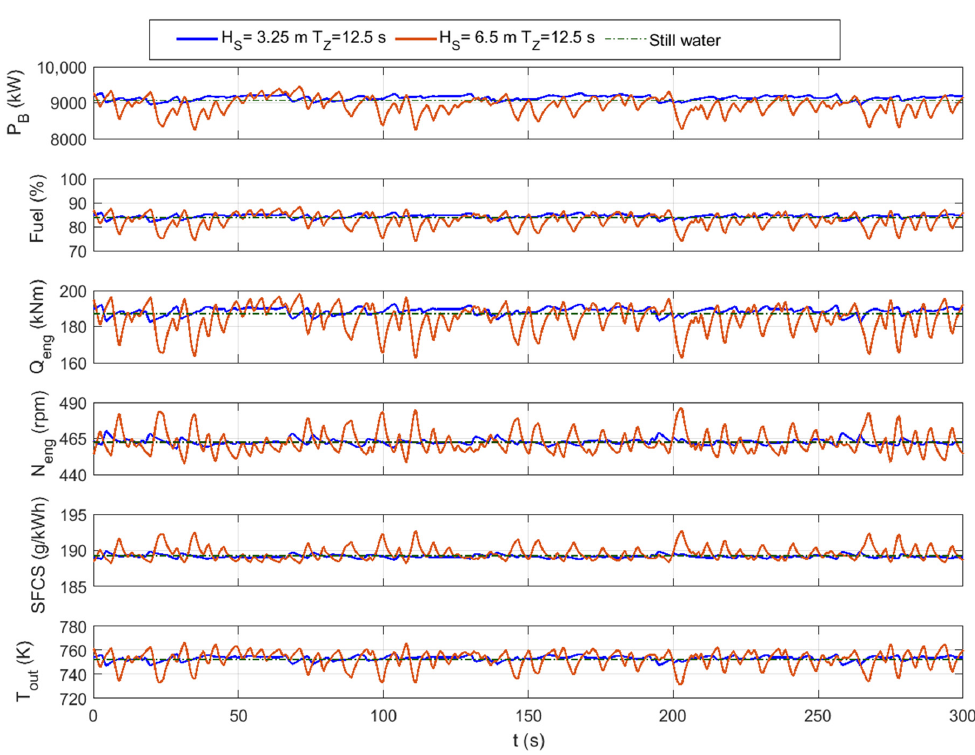
Figure 4. Time history of diesel engine performances in a head sea, for two proportional irregular sea states and still water.